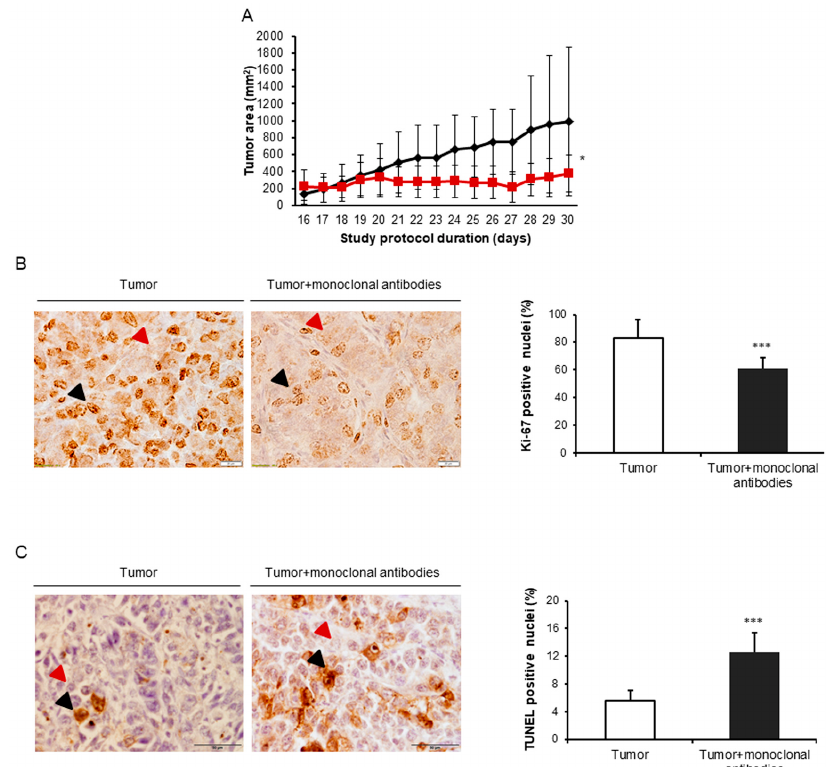
Figure 2. ( A ) Mean values and standard deviation of subcutaneous tumor area (mm 2 ) of non-treated control lung cancer group of mice (black color) and lung cancer mice treated with monoclonal antibodies group (red color) during the study protocol. ( B ) Representative histological sections (40 × ) and mean values and standard deviation of Ki-67 in the subcutaneous tumors of the non-treated control mice and the treated lung cancer animals. Black arrowheads point towards Ki-67-positively stained nuclei (brown color), while red arrowheads point towards Ki-67 negatively stained nuclei (purple color). ( C ) Representative histological sections (40 × ) and mean values and standard deviation of TUNEL in the subcutaneous tumors of the non-treated control mice and the treated lung cancer animals. Black arrowheads point towards TUNEL-positively stained nuclei (brown color), while red arrowheads point towards TUNEL-negatively stained nuclei (purple color). Statistical significance: *: p ≤ 0.05 and ***: p ≤ 0.001 between lung cancer mice compared to the lung cancer-monoclonal antibodies group.